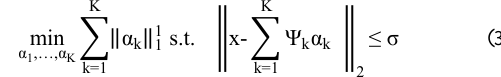
Figure 1. Geometry acquisition differences between the passes P0302, P0305 and P0306.